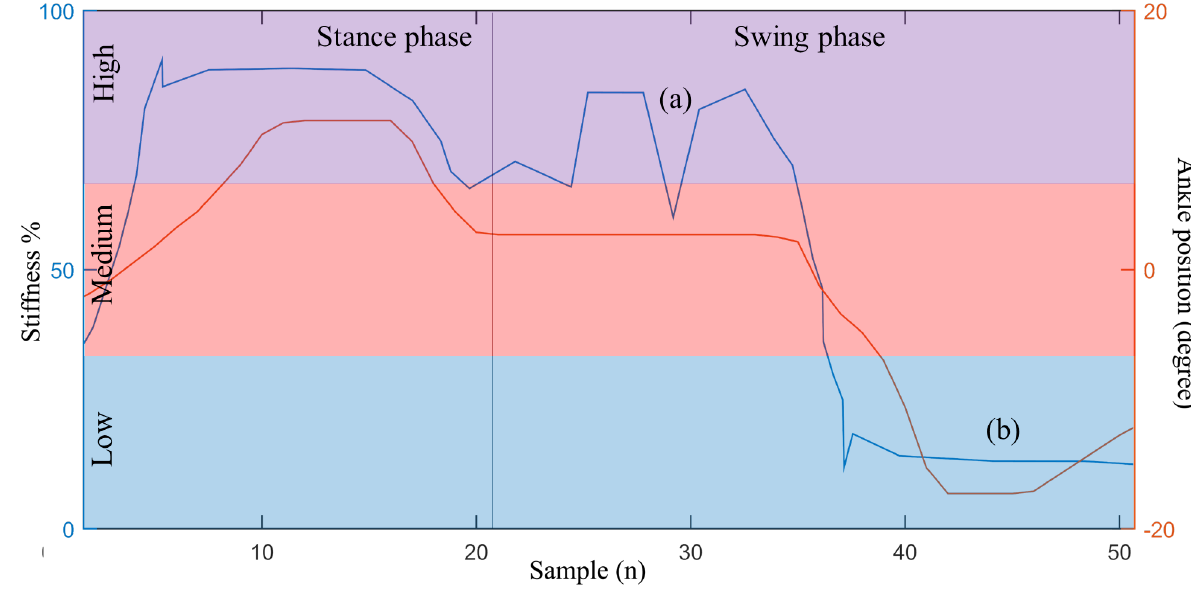
Figure 10: Practical applications result in implementing the trained network to PICAFO. (a) High stiffness at the initial swing phase prevents the foot drop; (b) Low stiffness at the end of the swing phase allows natural initial contact